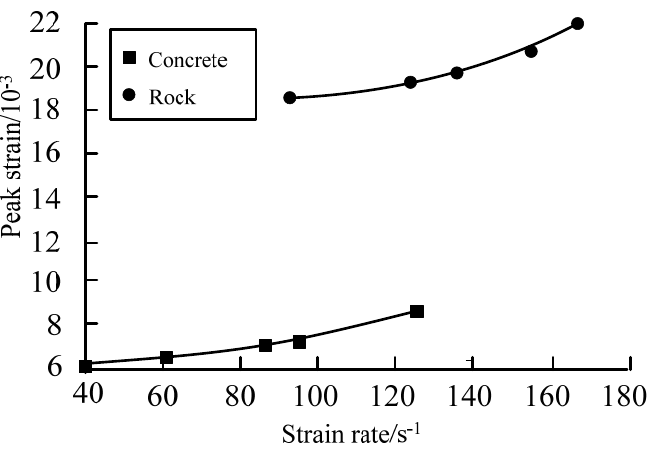
Figure 4: Correlation between peak strain and strain rate.